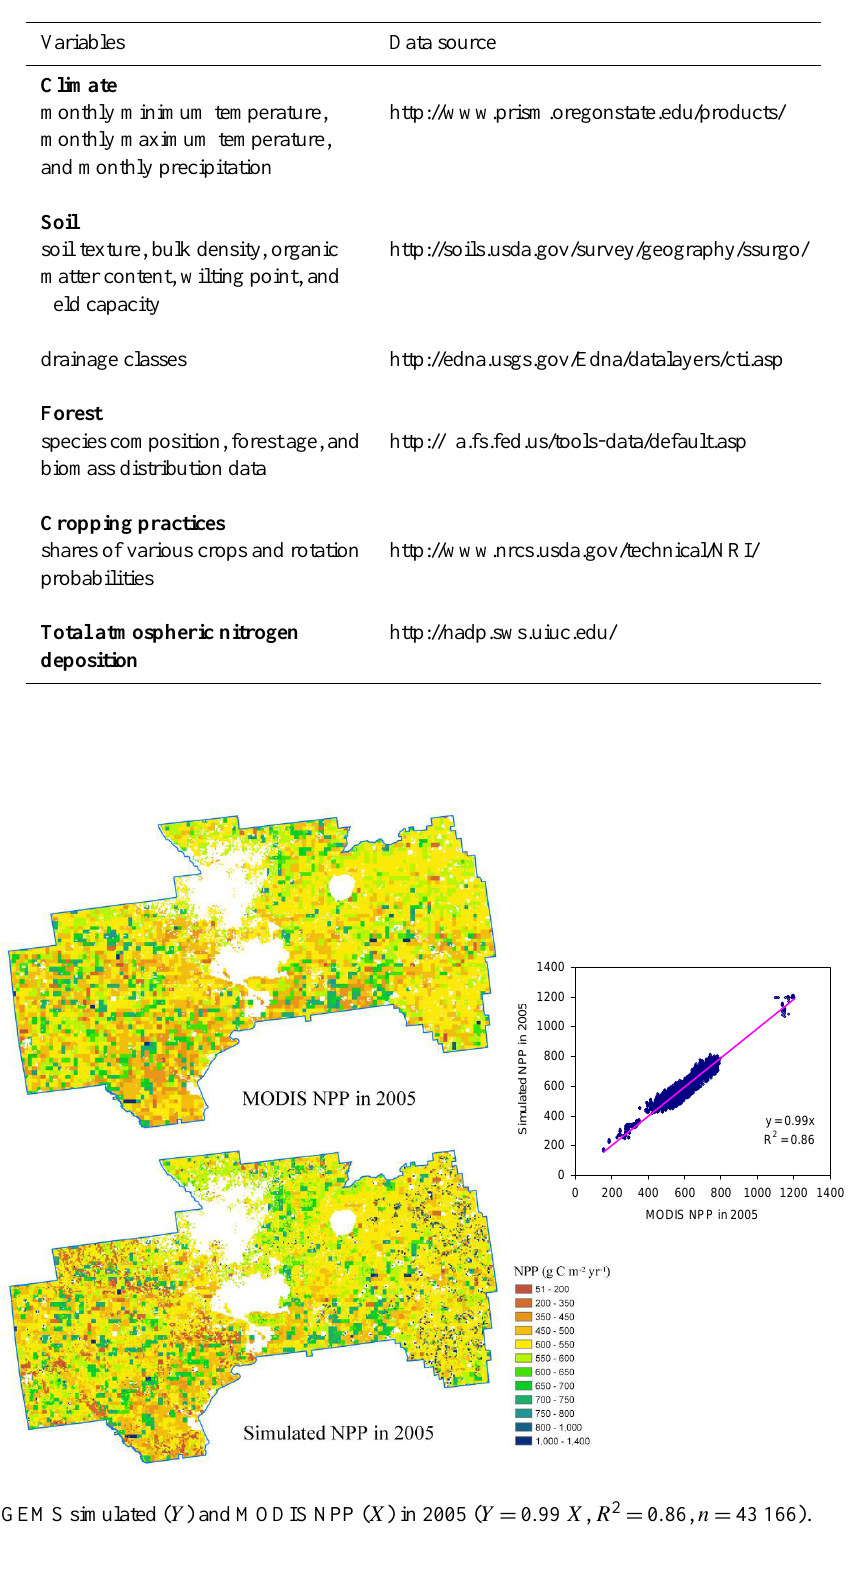
Table 1. Other geospatial data layers used in this study.